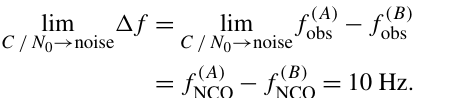
carrier signal-to-noise density ratio, σ(C /N 0 ) , calculated within the elevation angle range + 1 ◦ < (cid:15) < + 2 ◦ , is taken as proxy for the signal amplitude fluctuation.